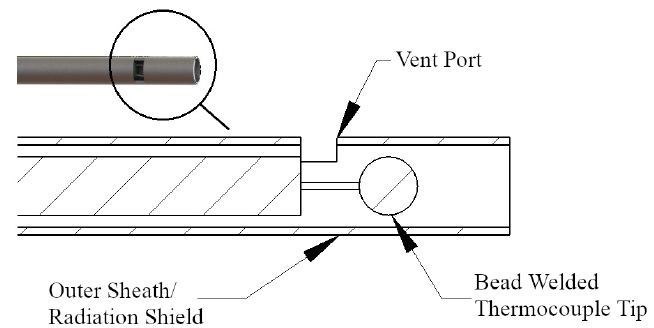
Figure 4. Schematic of thermocouple probe